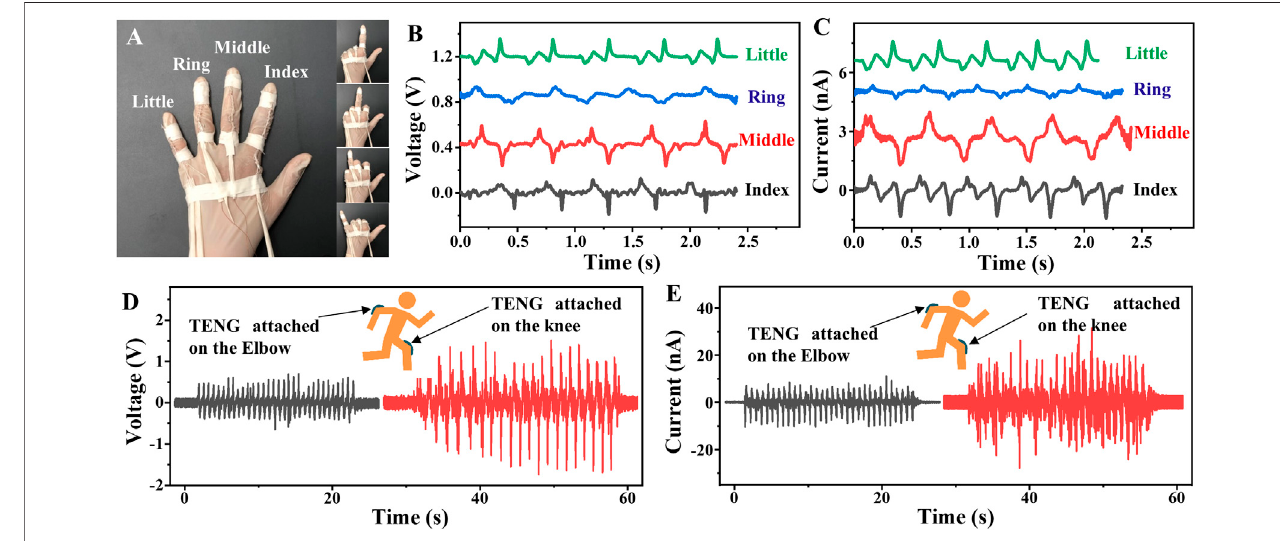
FIGURE4| Sensingfeaturestothehuman-bodymotions. (A) PhotographofahandwithfourTENGs fi xedonitsfour fi ngersfromtheindex fi ngertothelittle fi nger. (B,C) Voltage and current curves of the four TENGs fi xed on the four fi ngers. (D,E) Voltage and current curves of the TENG fi xed on the elbow and knee.